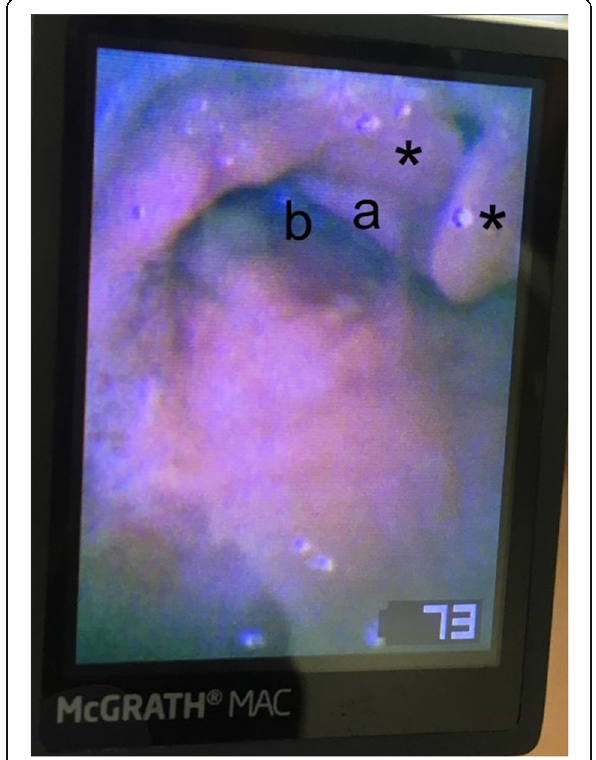
Fig. 1 Bifid epiglottis was seen using video laryngoscopy. Bifid epiglottis (*), corniculate cartilage (a), and esophagus